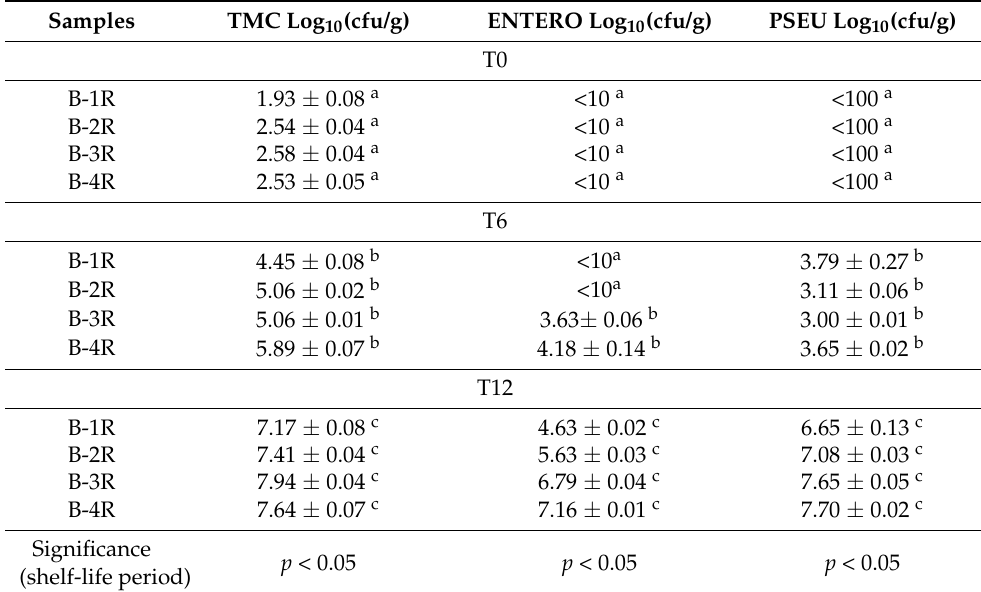
Table 2. Microbiological counts of the different ricotta samples during the shelf-life period. Data are expressed as mean values ± standard deviation (n = 3) of each